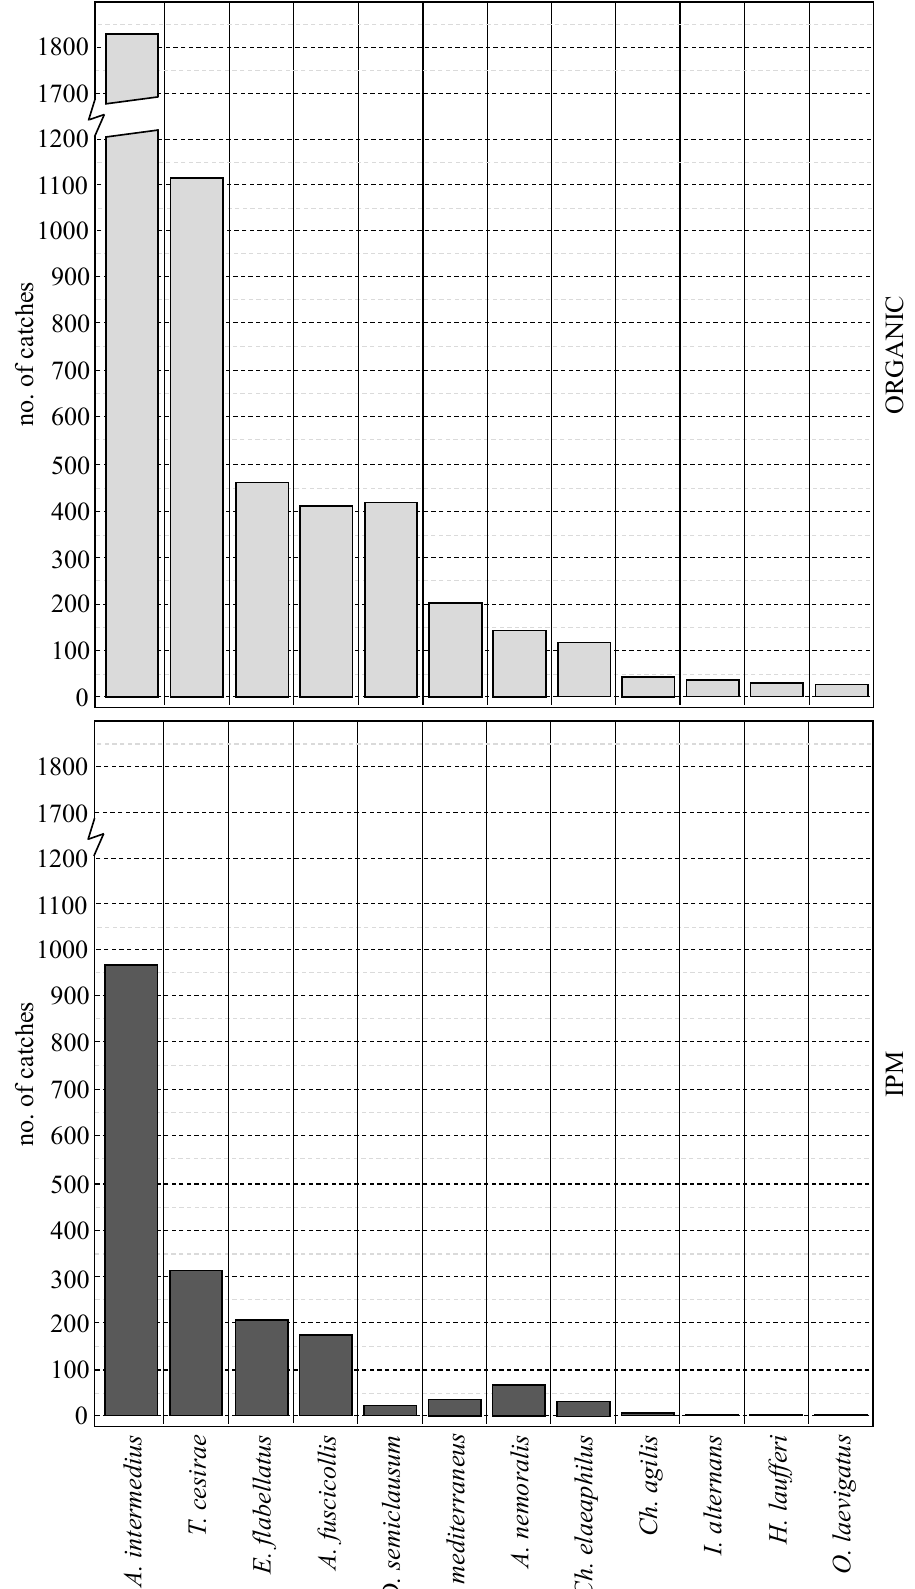
Figure 3. Abundance values obtained by the species in the control plots of the organic (light color) and IPM (dark color) olive groves.